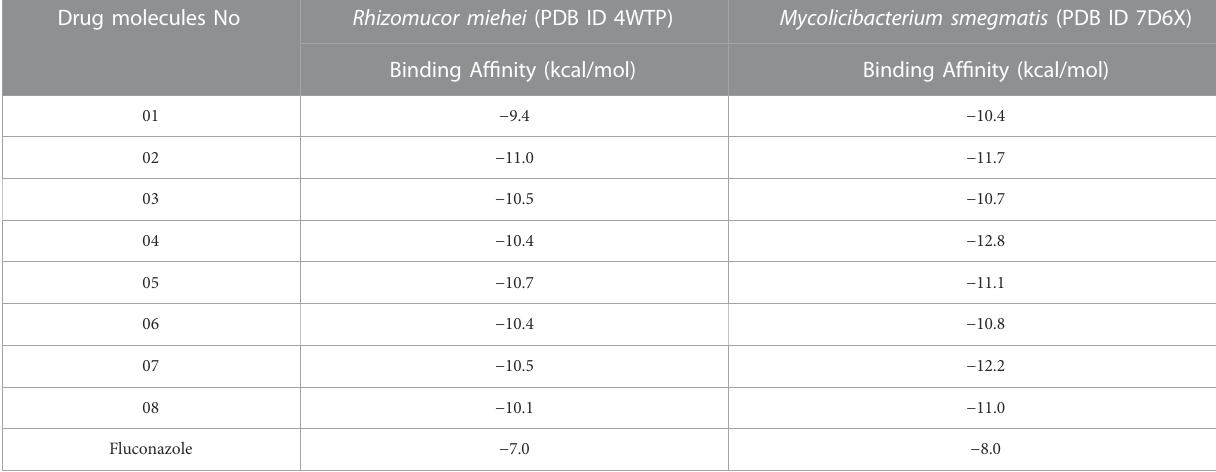
TABLE 3 Binding af fi nities of docked ligand calculated against Black Fungus. Drug molecules